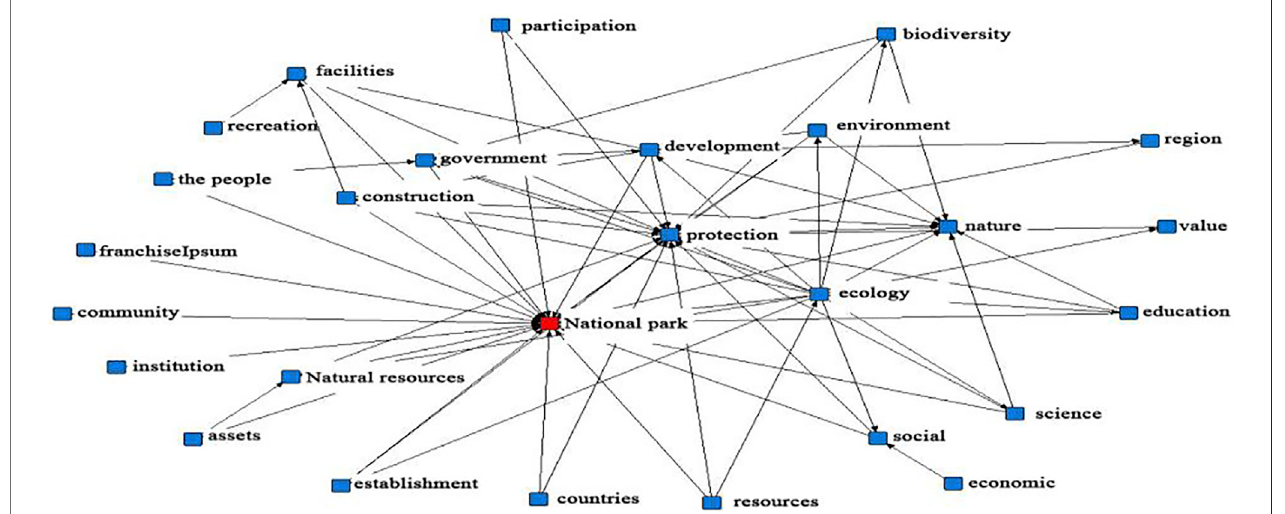
FIGURE 1 | Network diagram of the semantics of high-frequency words.